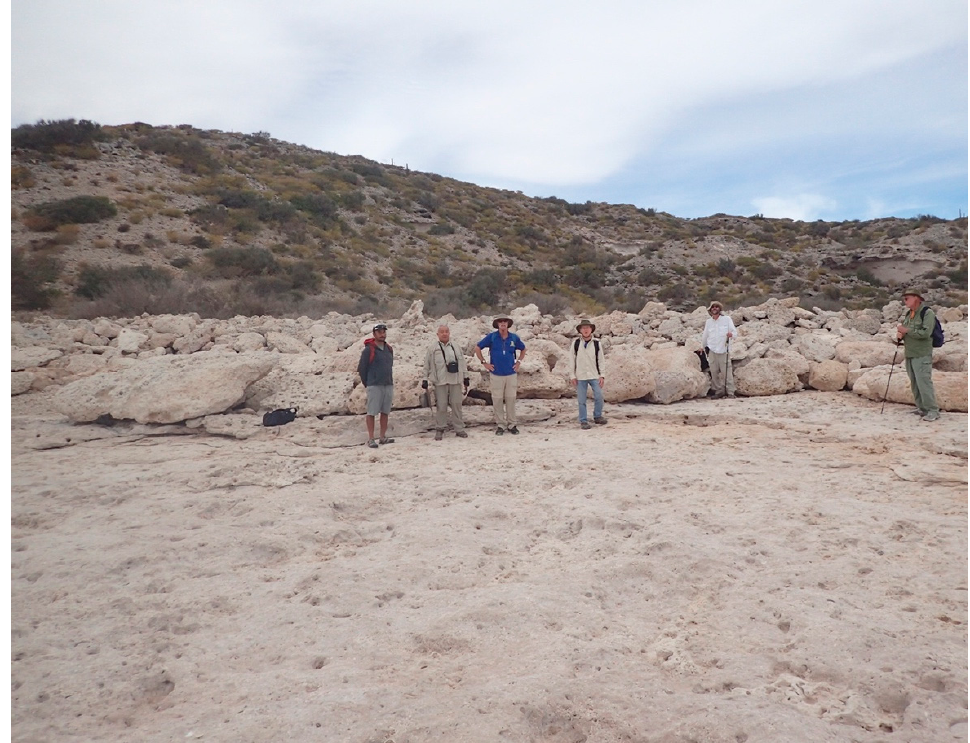
Figure 5. Portion of the coastal boulder deposit (CBD) formed by Pliocene limestone boulders that sit 25 m back from the outer rim of the 12-m terrace at Arroyo Blanco.